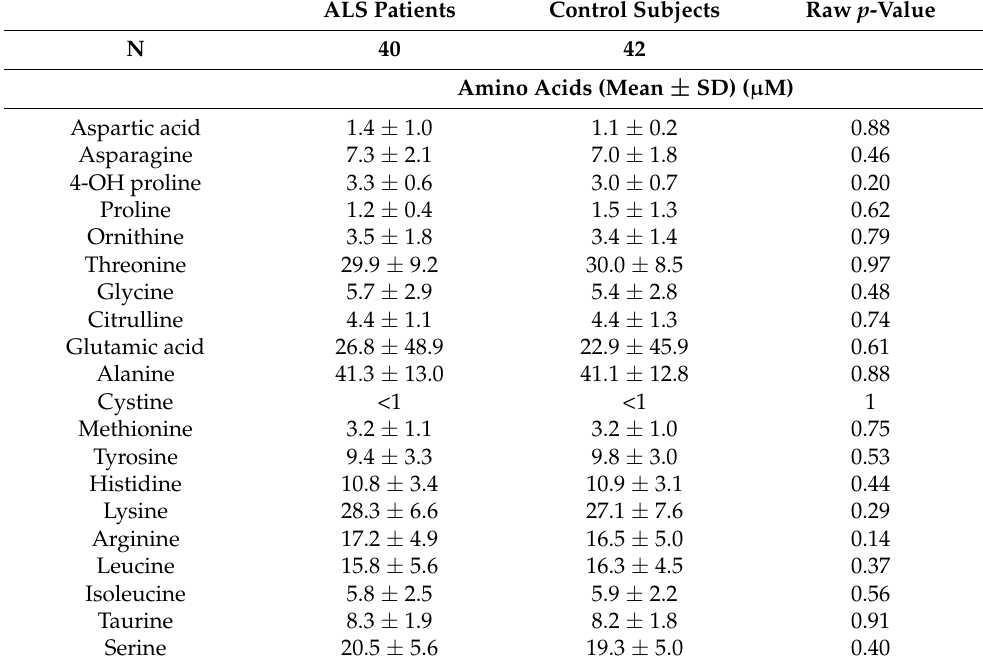
Table 2. Compounds found in the CSF of ALS and control subjects, before